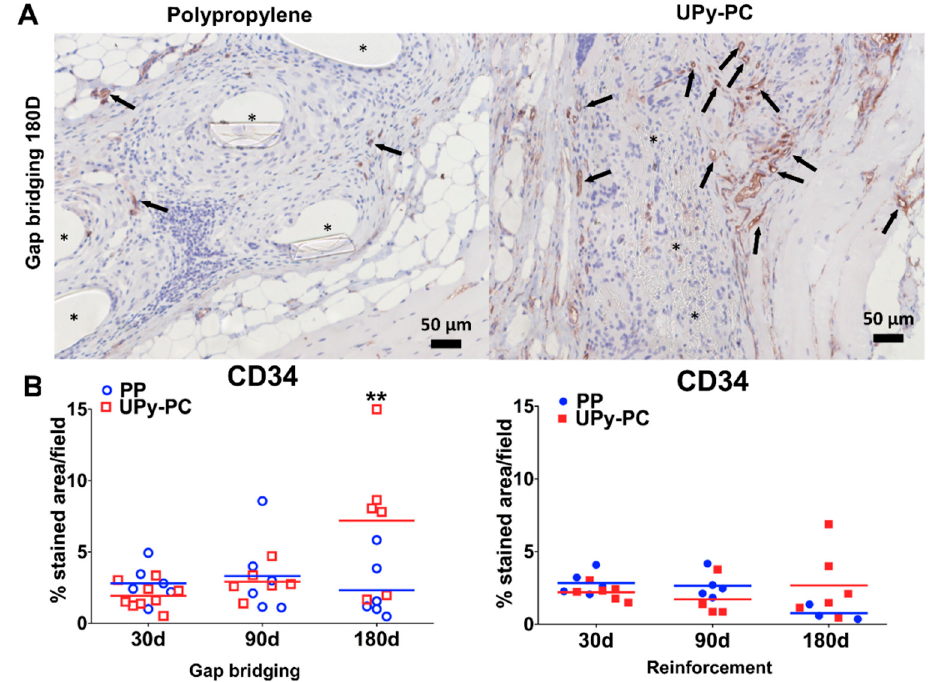
Figure 4. (A ) Representative images of CD 34 immunostaining at 200× magnification (endothelial cells stained brown). ( B ) Graphs of CD34 positive counts of gap bridging (left) and reinforcement (right). More abundant neovascularization was visible in UPy-PC at 180 days in the gap-bridging model. No significant difference was observed in the reinforcement model. Herniated samples are marked by a lighter colour (pink). ** p ≤ 0.01. PP: Polypropylene; UPy-PC: electrospun ureidopyrimidinone polycarbonate.